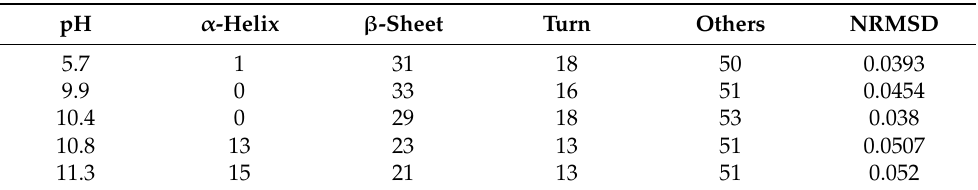
Figure 3. Circular dichroism spectra of P-Arg molecule at various pHs. The measurements were performed for ionic strength of 10 − 2 M NaCl at T = 298 K. Table 3. The percentage of the secondary structure contents for P-Arg at different pH at I = 10 − 2 M NaCl and T = 298 K.